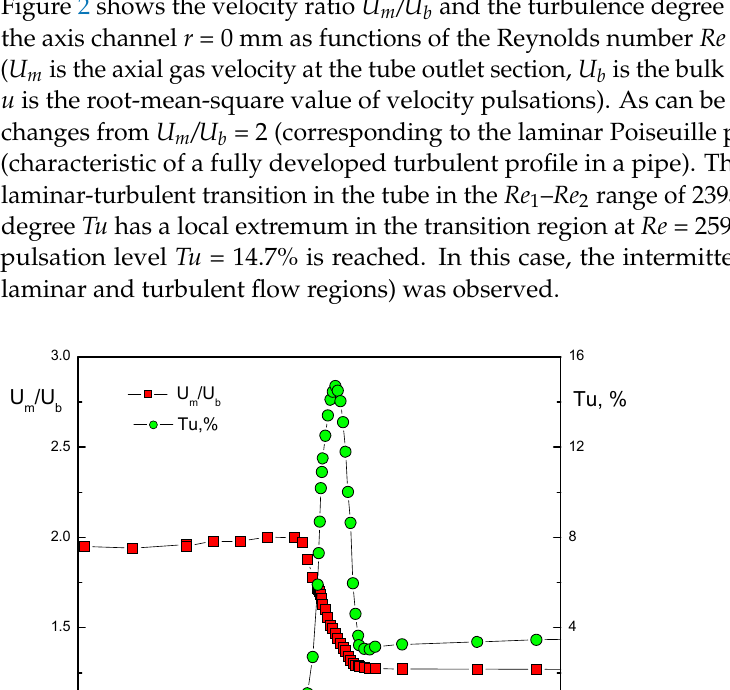
Figure 1. Experimental setup scheme.